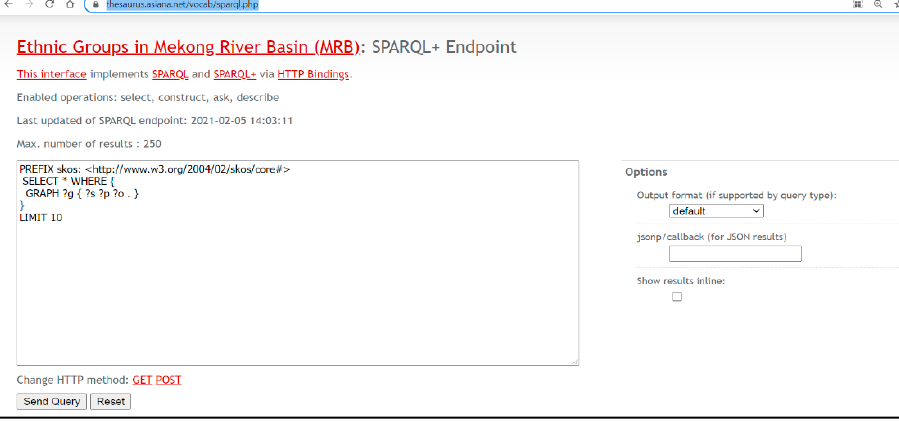
Figure 7. Screen shot of the SPARQL endpoint of the digital thesaurus of ethnic groups in the MRB.